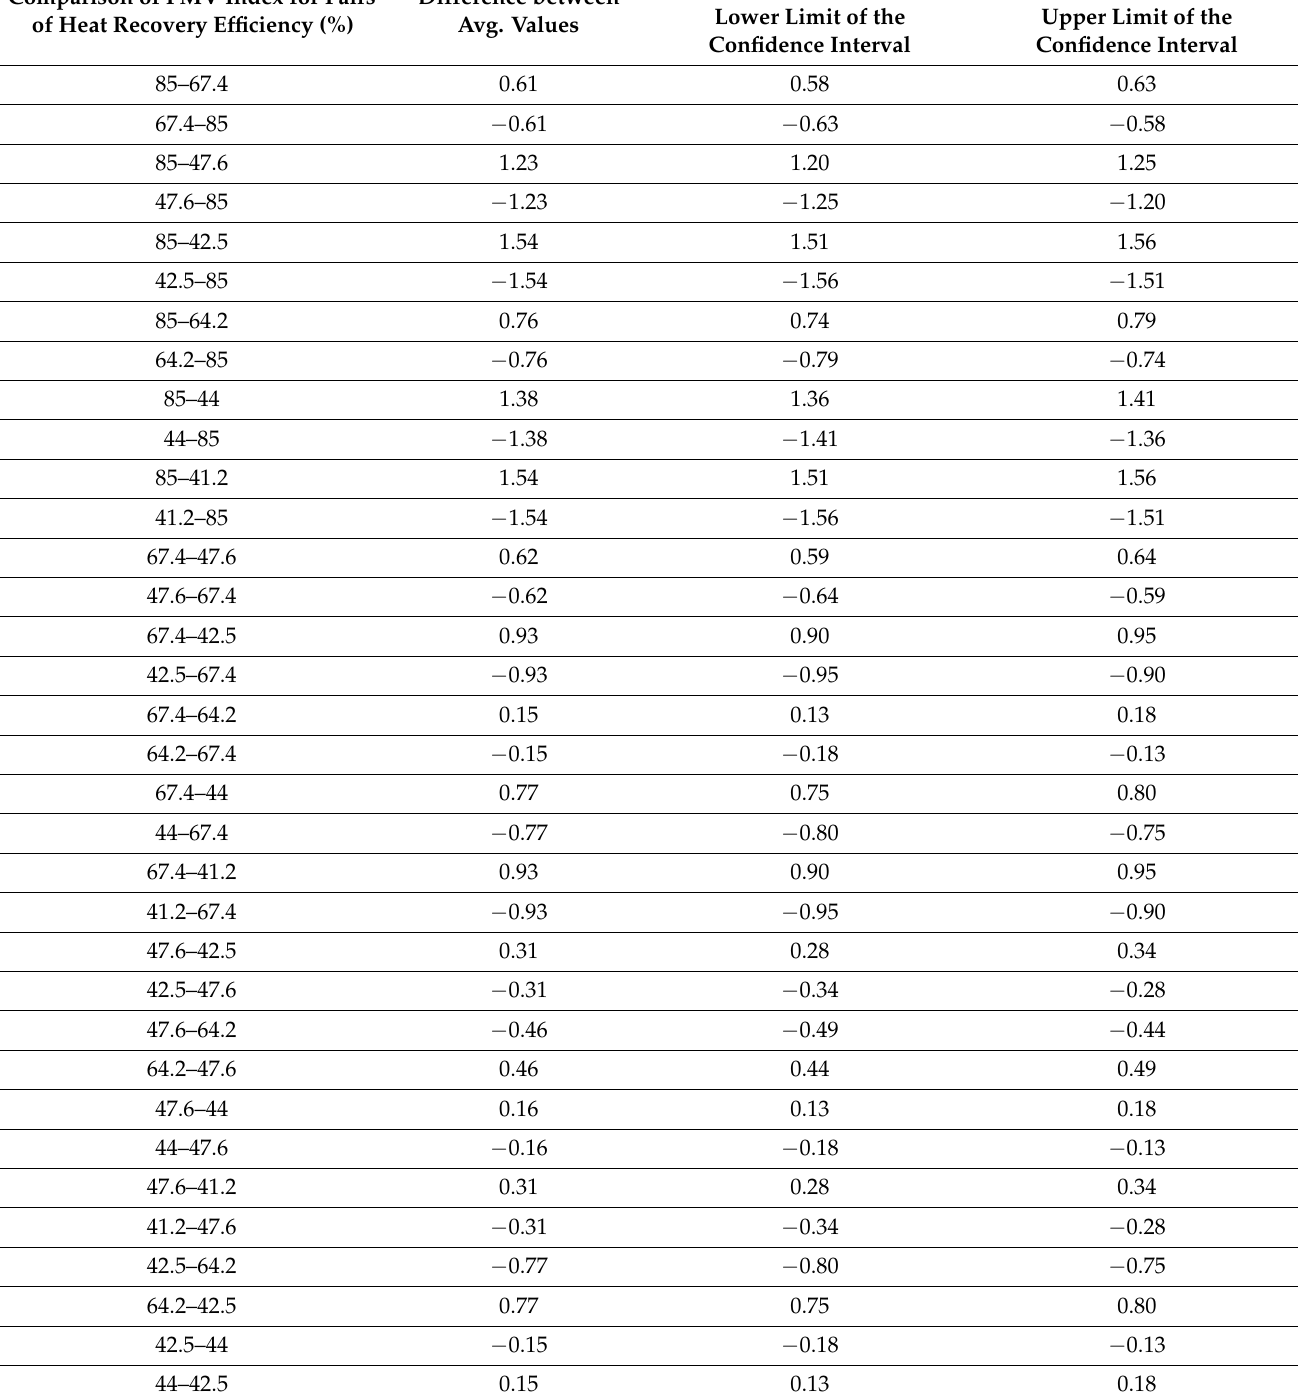
Table 8. Simultaneous 95% confidence intervals obtained using the Tukey method for difference in avg. values of PMV index in groups matching efficiency of heat recovery levels. Supply/exhaust cycle: 10